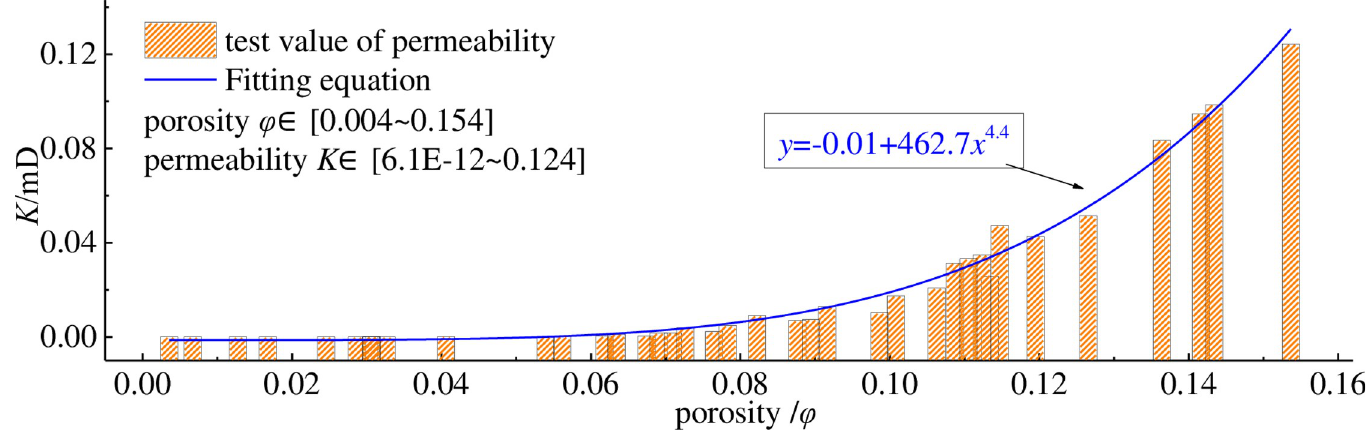
Fig 5. History of pore-associated permeability values.